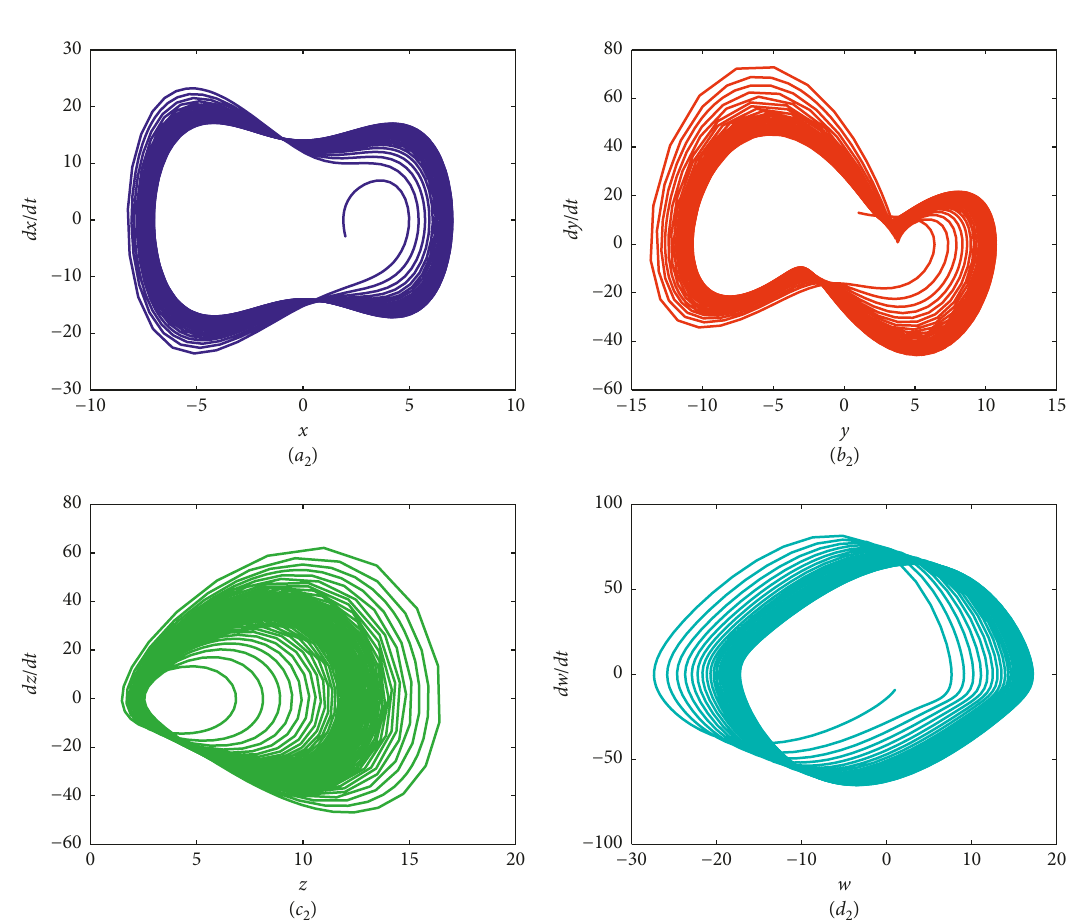
Figure 5: Phase diagrams of Experiment 1 with a � 3 , b � 5 , t � 100: ( a ) phase diagram of w of z ; ( d 2